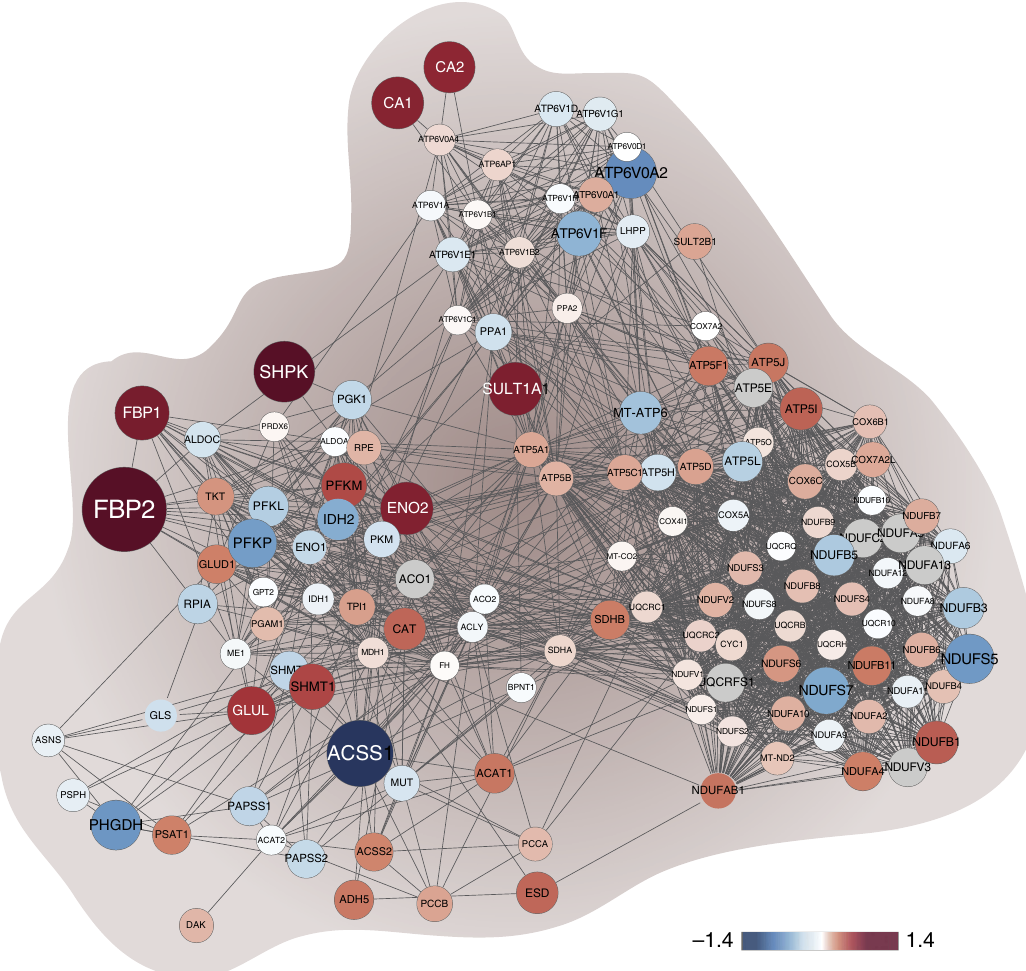
Figure 4 | Energy metabolism protein–protein interaction network in ERPR tumours. Protein–protein interaction network of all proteins in our data set that mapped to the ‘energy metabolism’ KEGG category was constructed in String (www.string-db.org). The color of the nodes correspond to the protein expression fold change between the ERPR and the two other subtypes; red indicates higher expression and blue—lower expression in the ERPR subtype. The size of the nodes corresponds to the absolute protein expression fold